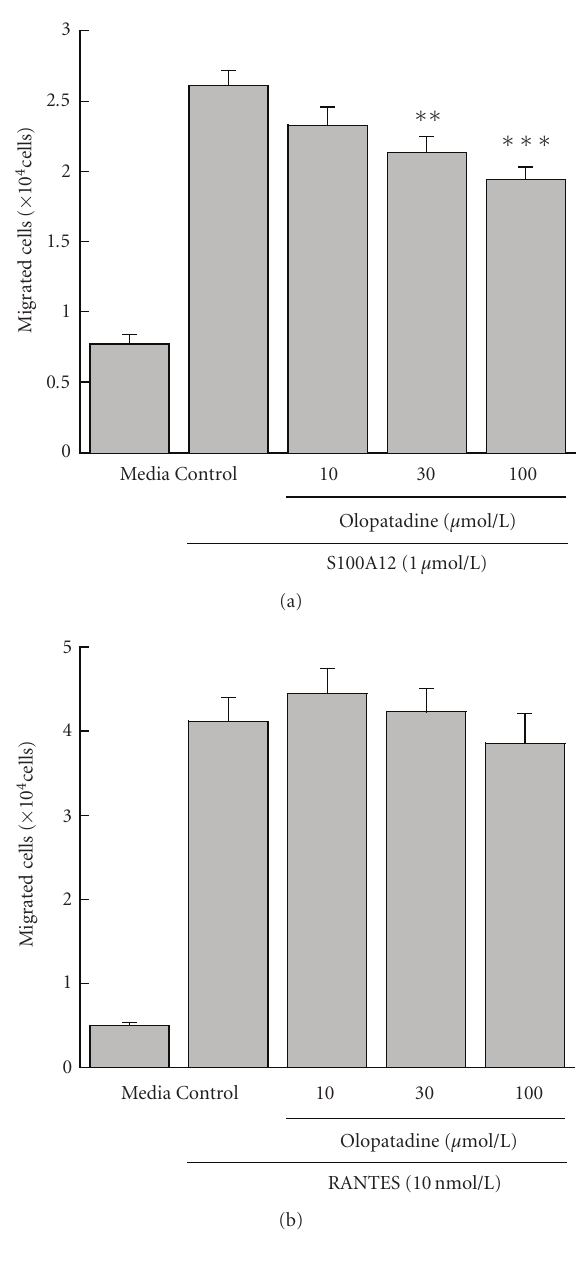
Figure 1: E ff ects of olopatadine on the migration of THP-1 cells in- duced by S100A12 (a) or RANTES (b). The numbers of cells migrat- ing toward S100A12 (1 μ mol/L) or RANTES (10 nmol/L) during 3h incubation were determined by flow cytometry. The values in panel (a) are means ± SE from 3 independent experiments ( n = 9), and those in panel (b) are means ± SE from 2 independent experiments ( n = 6). ∗∗ P < 0 . 01; ∗∗∗ P < 0 . 001 (versus control, Dunnett’s test). Media, spontaneous migration.